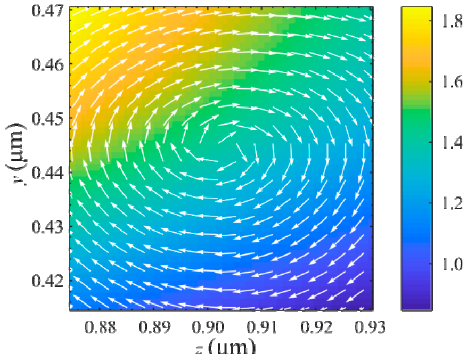
Figure 4. Intensity distribution (color) and directions of the Poynting vectors (arrows) in the region of the toroidal vortex that rotates clockwise and is nearest to the r - and z -axes (area 1 in Figure 3a).